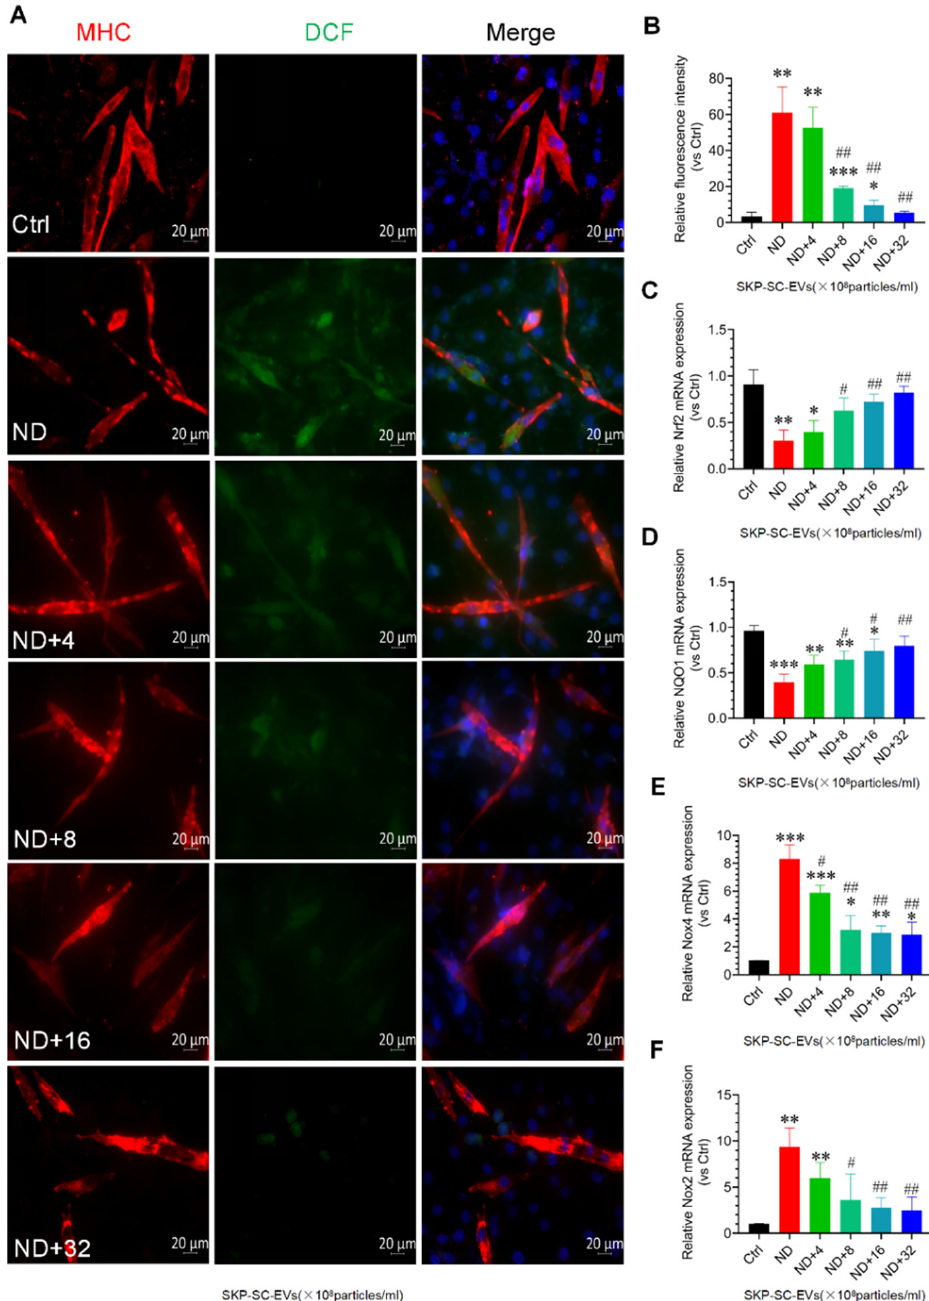
Figure 4. SKP-SC-EVs inhibit oxidative stress of myotubes after nutrient deprivation. ( A ) DCF stain- ing images of myotubes 12 h after treatment with HBSS with or without SKP-SC-EVs (4 × 10 8 , 8 × 10 8 , 16 × 10 8 , and 32 × 10 8 particles/mL). Red and green represent MHC staining and DCF staining, respectively. Blue fluorescence in far right panels represent DAPI-stained nuclei. Scale bar = 20 µ m. ( B ) Histogram indicating that SKP-SC-EVs inhibit oxidative stress of atrophic myotubes after nutrient deprivation. n = 4, * p < 0.05, ** p < 0.01, and *** p < 0.001 vs. Ctrl group; ## p < 0.01 vs. ND group. ( C – F ) qRT-PCR analysis of oxidative stress-related genes Nrf2, NQO1, Nox4, and Nox2 in myotubes. n = 3, * p < 0.05, ** p < 0.01, and *** p < 0.001 vs. Ctrl group; # p < 0.05 and ## p < 0.01 vs. ND group. Ctrl, control; DCF, dichlorofluorescein; EVs, extracellular vesicles; HBSS, Hank’s balanced salt solution; ND, nutritional deprivation; SCs, Schwann cells; SKP, skin-derived precursors.